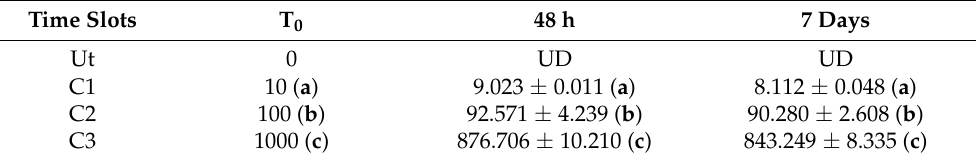
Table 1. TiO 2 concentrations ( µ g · L − 1 ) measured in untreated control (Ut) and treated (C1-3) waters at the start of the experiment (T 0 ) and after 48 h and 7 days. Undetected (UD). Different letters next to values indicate significant differences ( log -transformed data, Tukey’s HSD test, p < 0.05). Time